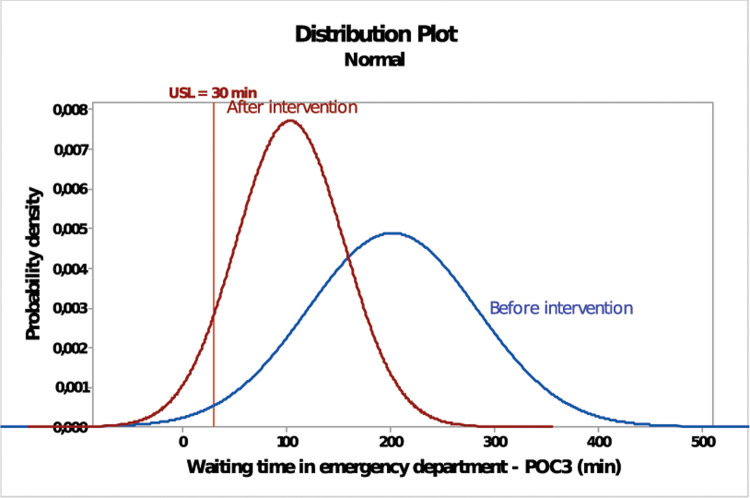
Before-after intervention in POC3.